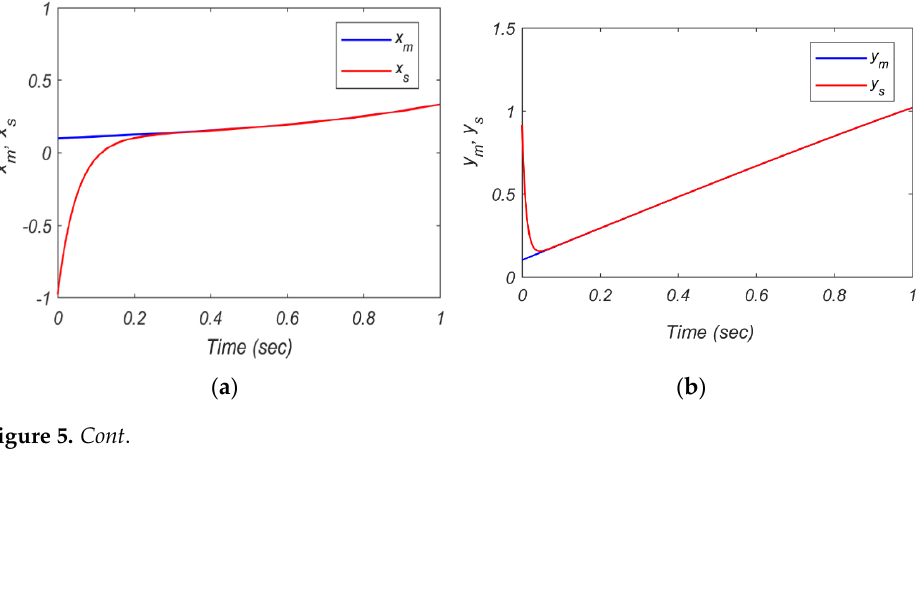
( c ) Figure 5. State variable synchronization of systems (10) and (11): ( a ) x m -x s ; ( b ) y m -y s ; ( c ) z m -z s .